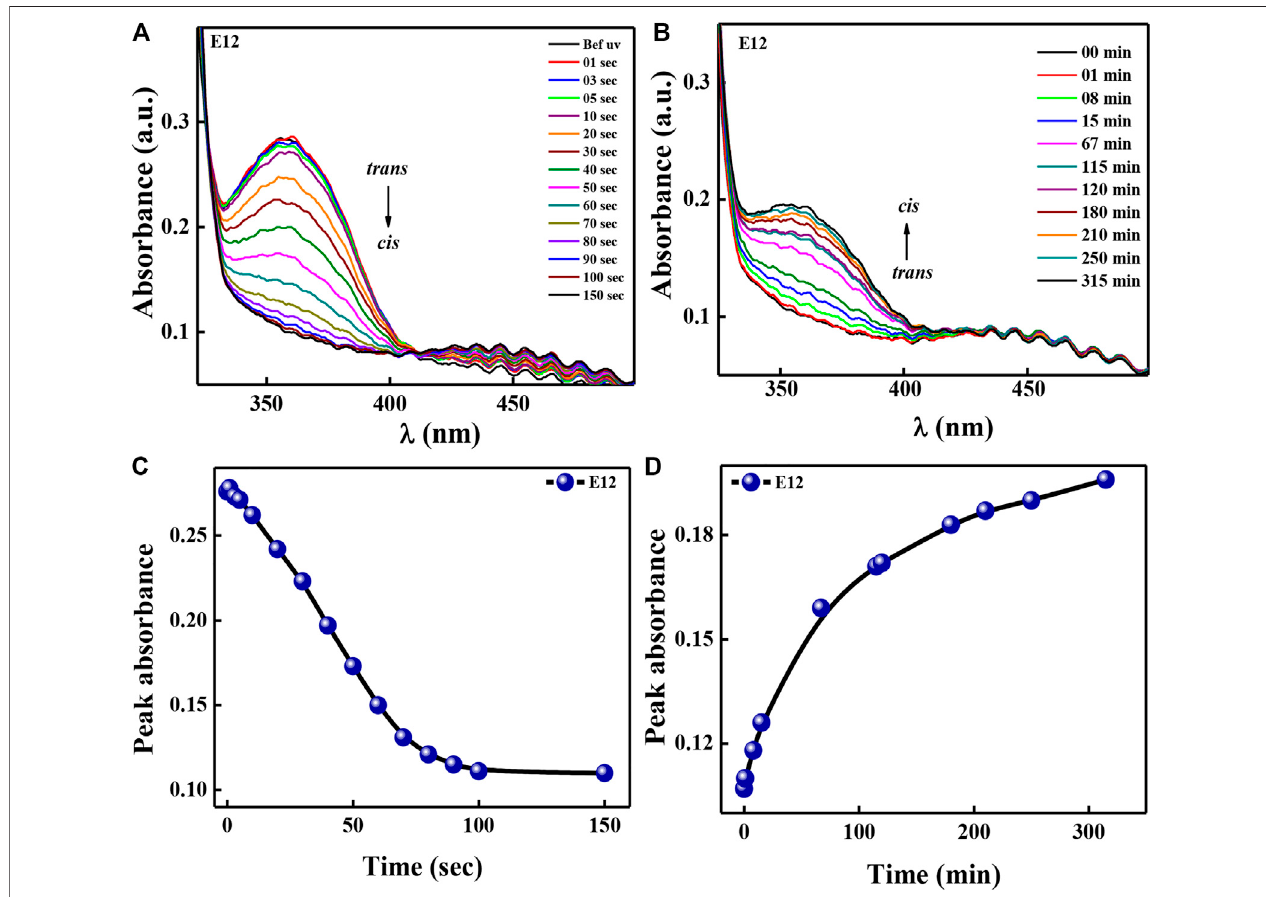
FIGURE8| SpectralinvestigationforHSLCsinasolidcellcon fi gurationduringUVillumination (A) andthermalbackrelaxation (B) .Peakabsorbanceplot (C,D) was plotted by extracting absorbance values at peak wavelength from fi g (A,B) .